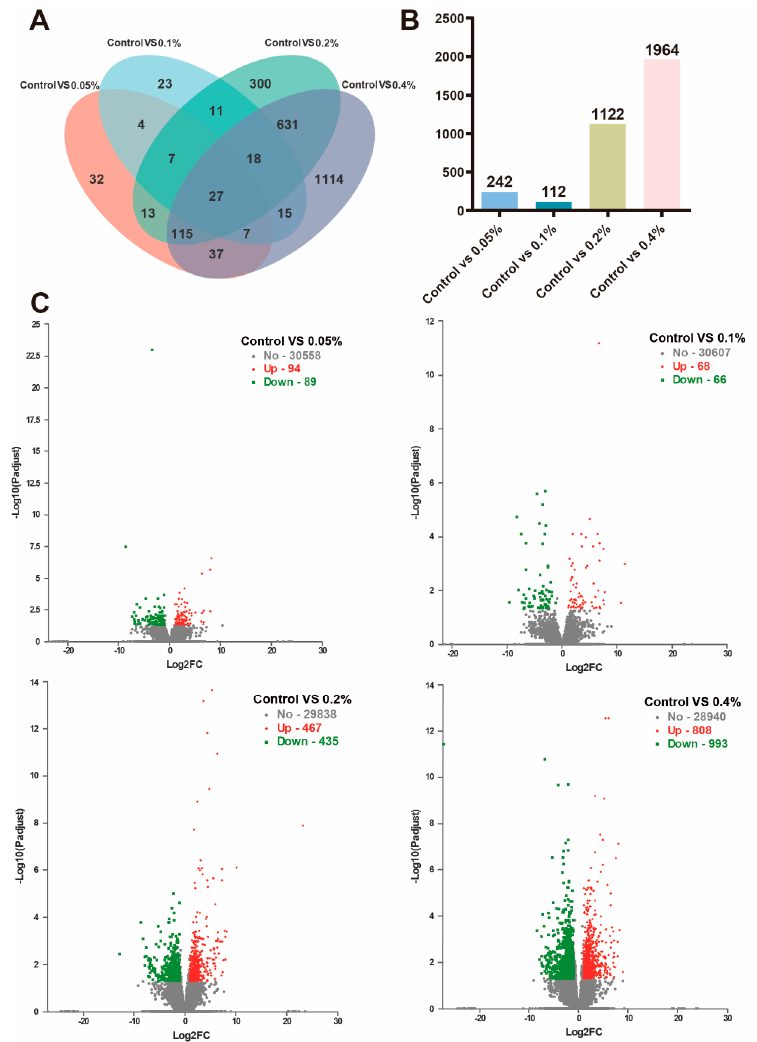
Figure 7. Changes in transcriptome levels of differentially expressed genes with different doses of β -glucan in Juvenile L. vannamei . ( A , B ) The Venn diagram shows the number of common or unique differential genes among groups (0.05%, 0.1%, 0.2% and 0.4%) compared with the control group. ( C ) Volcano map showing the number of upregulated and downregulated genes in the control vs. 0.05%, control vs. 0.1%, control vs. 0.2% and control vs. 0.4% groups; the X -axis is represented by log2 (fold change), and the larger the variation, the wider the distribution; the Y -axis is represented by − log10 (Padj), a negative logarithm of the adjusted p -value; the green dots represent downregulated genes, the red dots represent upregulated genes, and the gray dots represent genes that do not differ significantly ( n = 4).